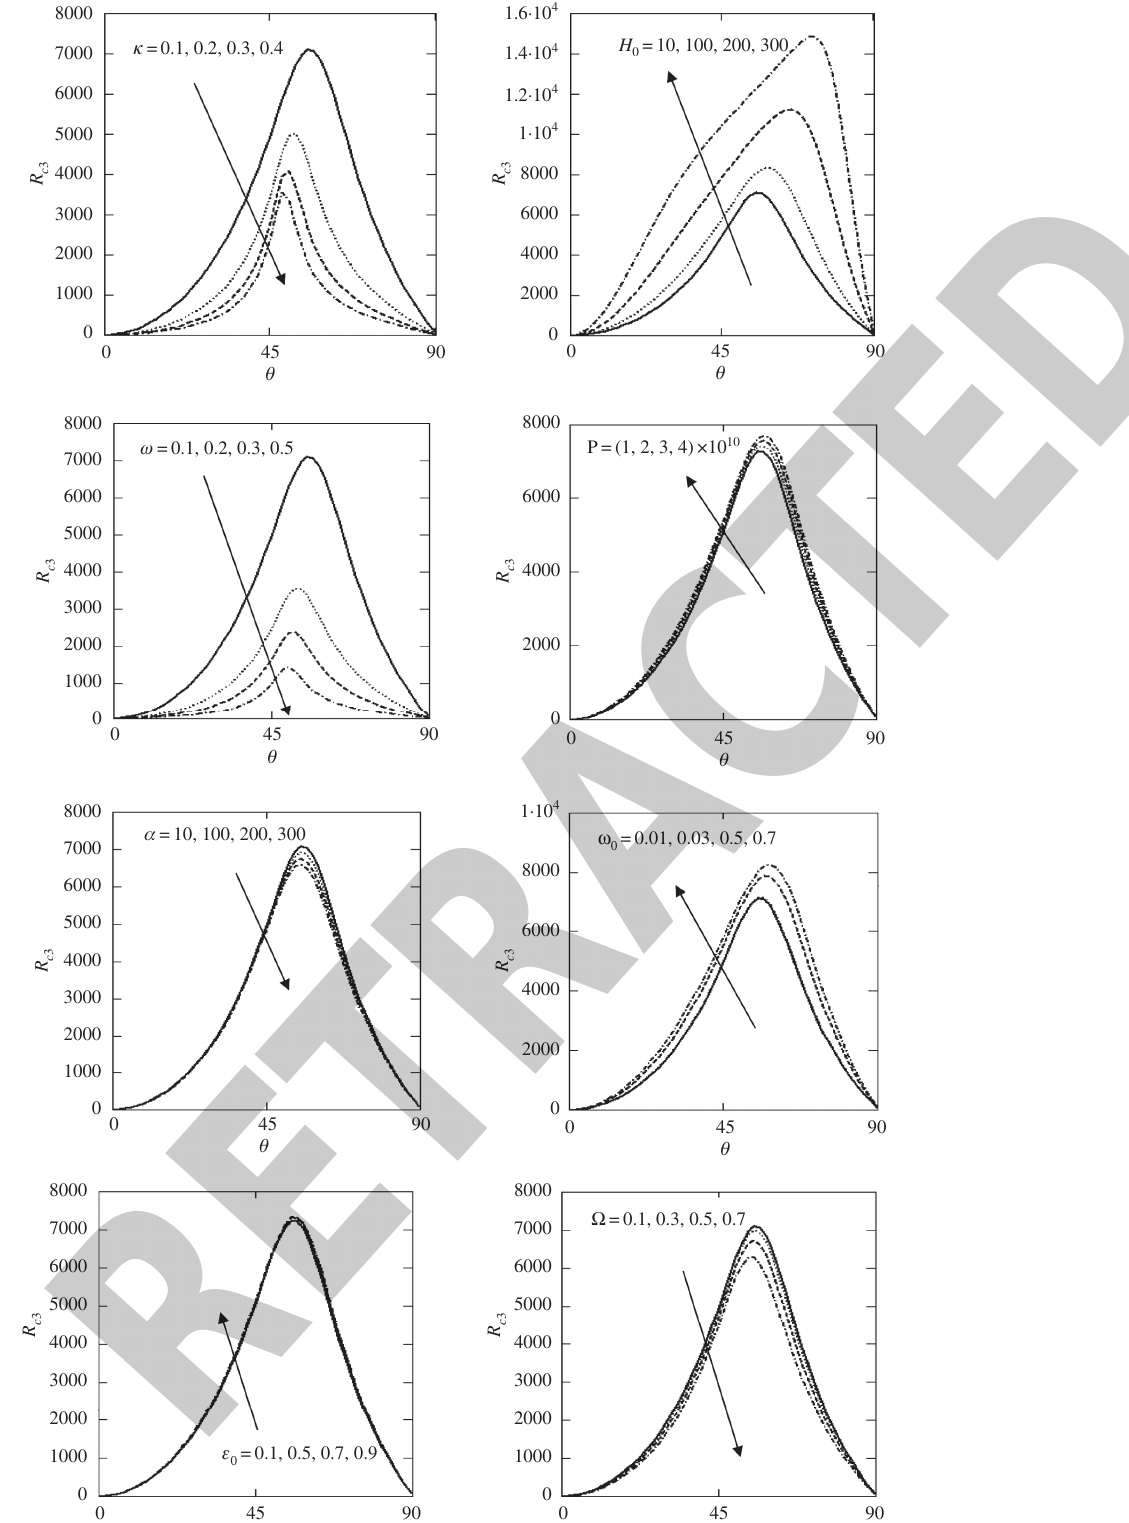
of the SV- (SV) wave with variation of κ , H c3